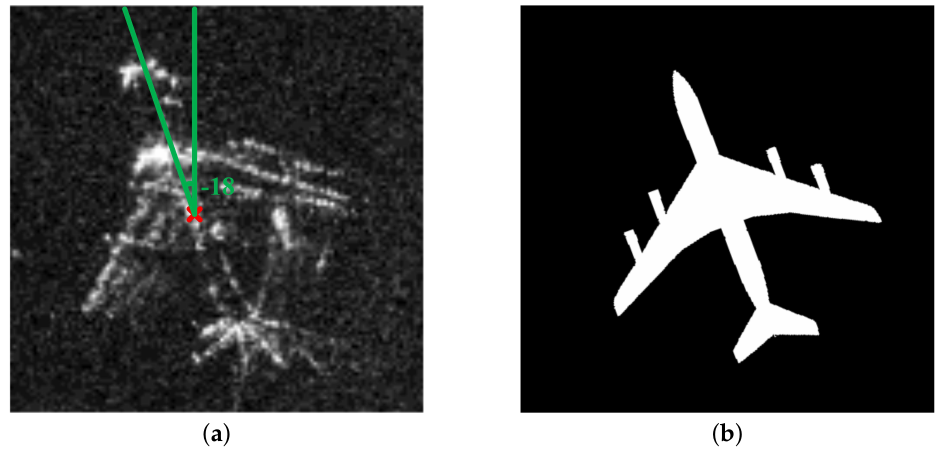
Figure 3. Example of the ground truth of the validation data slice: ( a ) labelled location (the red cross) and angle (the green text), and ( b ) the ground truth of data slice in ( a ).